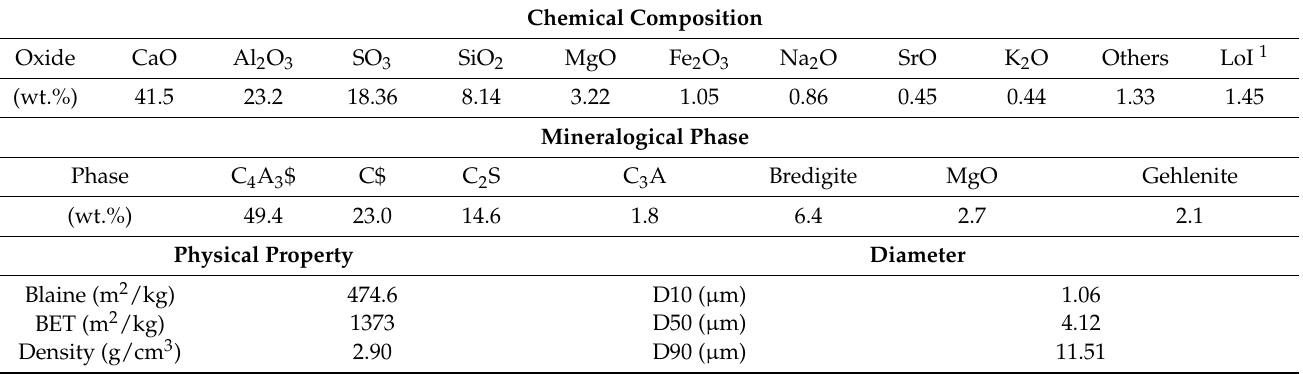
Table 3. CSA chemical and physical composition and mineralogical